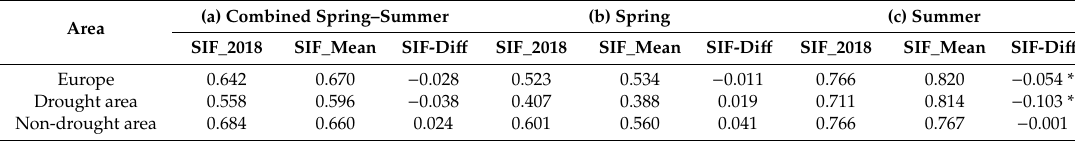
Table 1. European-wide mean SIF_757nm (W / m 2 / sr / µ m) values in spring, summer, and the combined spring–summer season and their corresponding anomaly (SIF-Di ff ) for whole of Europe, drought area and non-drought area.